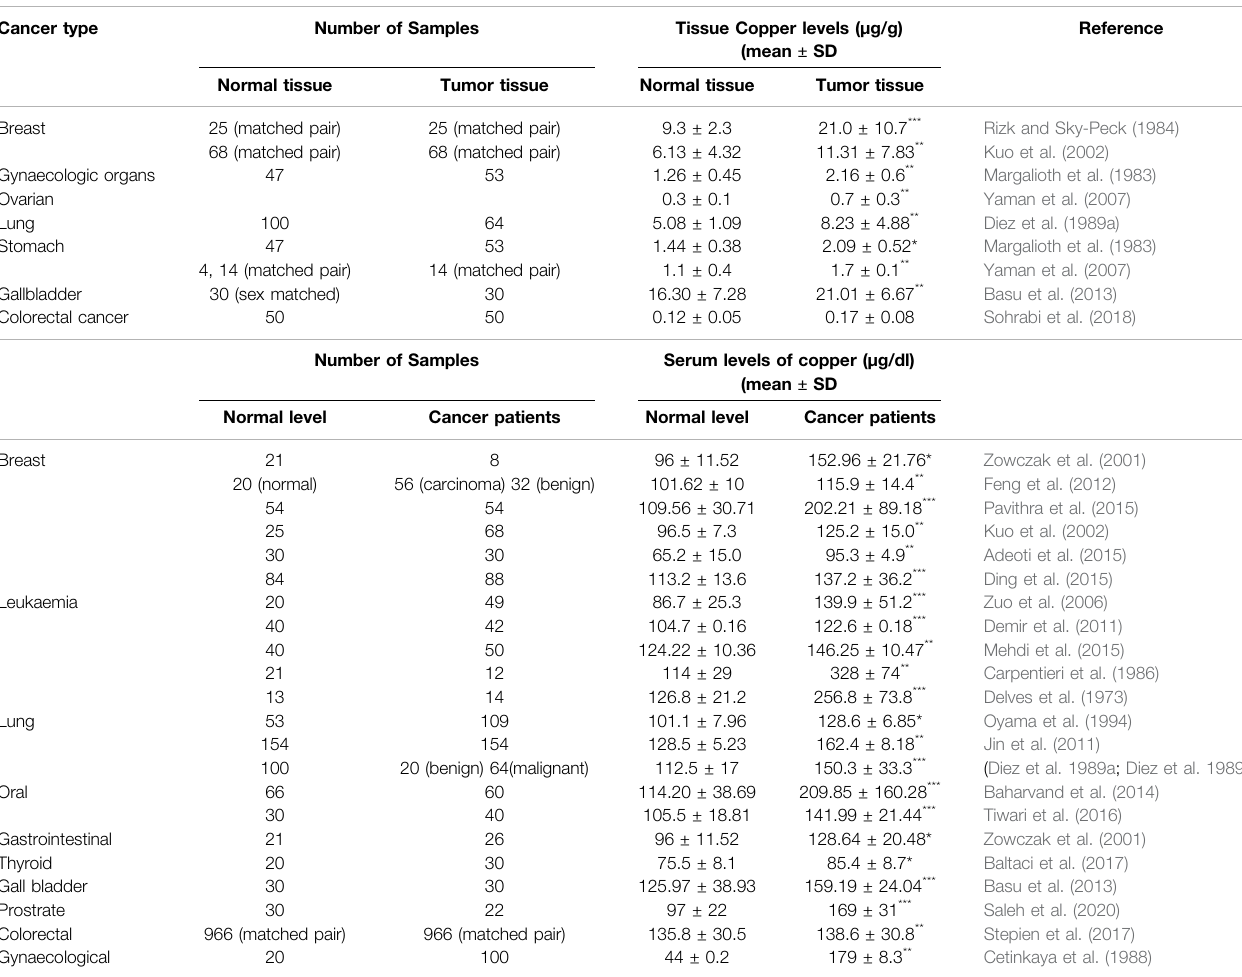
TABLE 1 | Tissue and serum levels of copper in normal and cancer patients (*** p ≤ 0.001, ** p ≤ 0.01, * p ≤ 0.05). Cancer